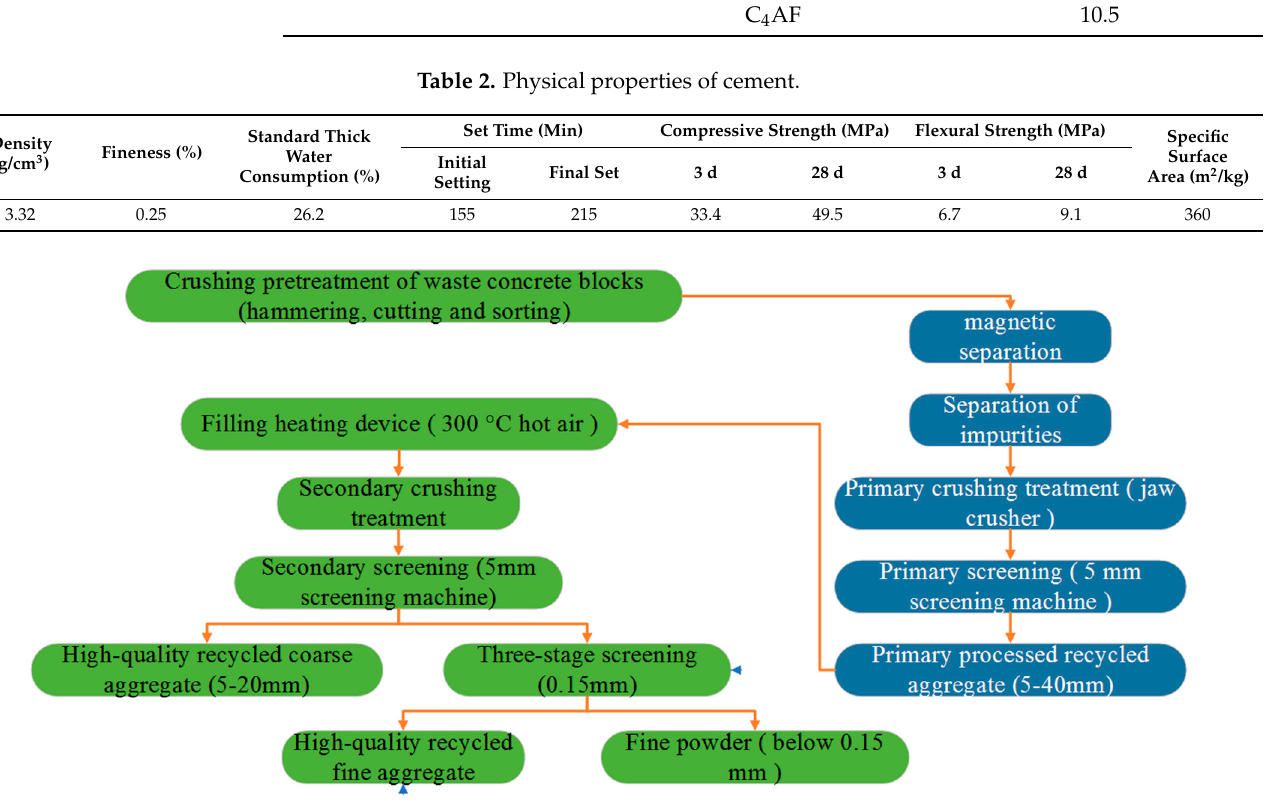
Figure 1. Recycled coarse aggregate content (RCA) production process.